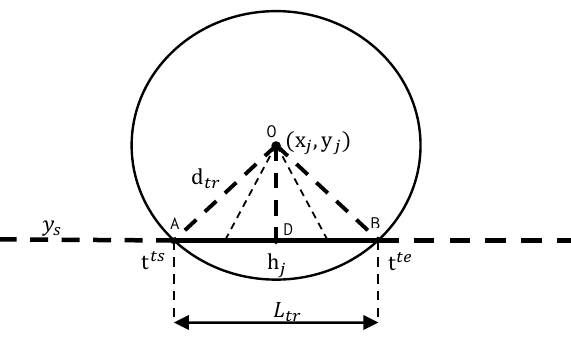
Figure 4. Distance model.